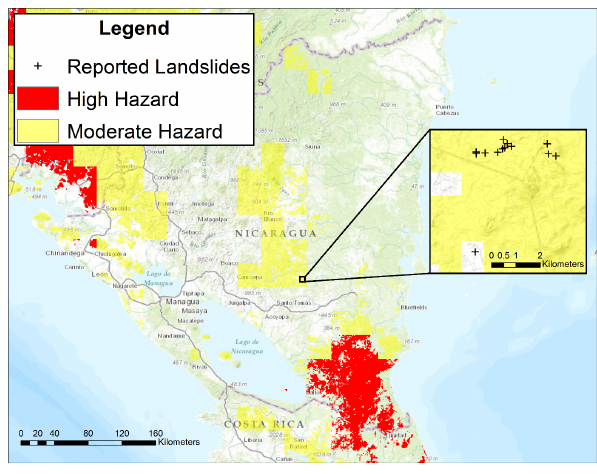
Figure 10. Landslide hazard potential for 23 June 2014. Black crosses indicate locations where a cluster of landslides occurred near El Ayote, Nicaragua. Yellow pixels (moderate hazard) and red pixels (high hazard) are shown for that day. Of 14 landslides, 13 were predicted by the moderate-hazard category. The southern- most landslide was located in a relatively flat location that had been mapped as having “very low” landslide susceptibility, so it was not predicted despite daily rainfall exceeding the 50th percentile thresh-